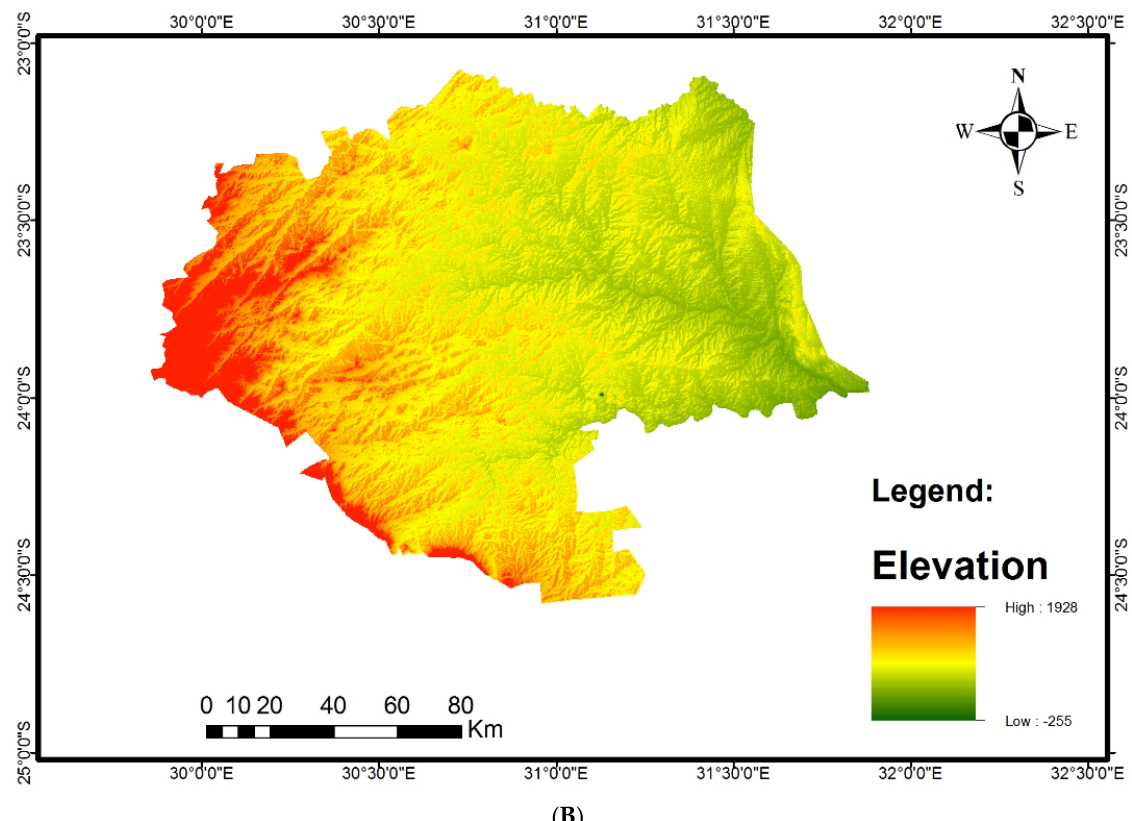
Figure 2. ( A ) Land uses and land cover classification and ( B ) Digital elevation across Mopani District Municipality.